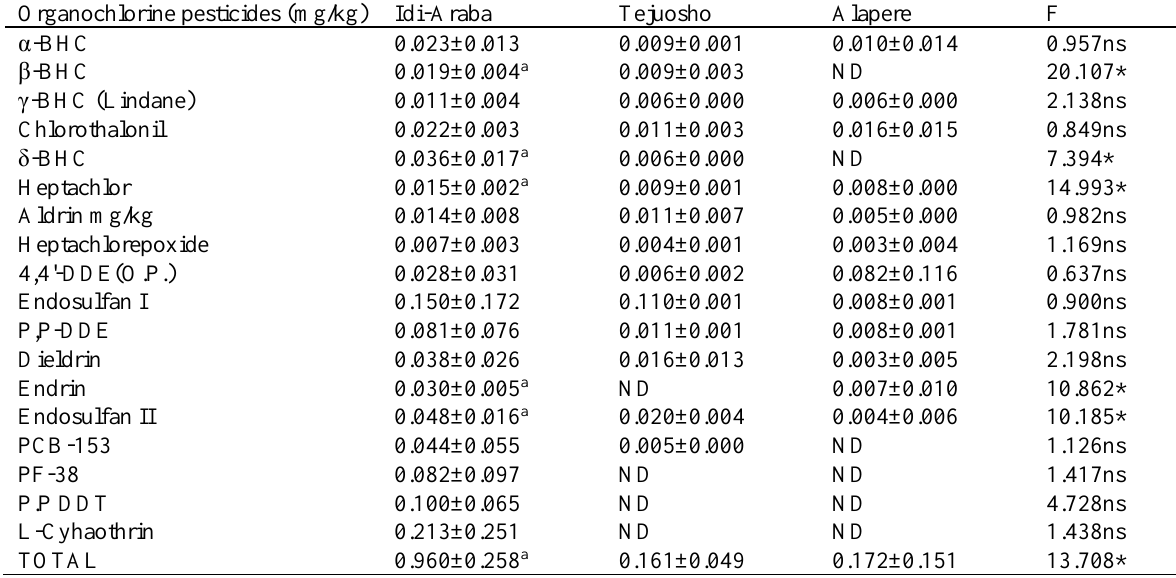
Table 2. Residual organochlorine concentrations in soils of sampled farms Organochlorine pesticides (mg/kg) Idi-Araba Tejuosho Alapere F α-BHC 0.023±0.013 0.009±0.001 β-BHC γ-BHC (Lindane) Chlorothalonil Heptachlor 0.015±0.002 a 0.009±0.001 Aldrin mg/kg 0.014±0.008